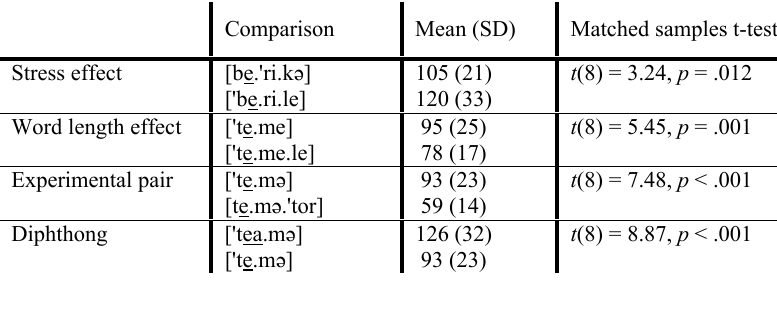
Table 2. Means, standard deviations and results for matched-samples t-tests for the vowel duration measure. The vowel tested is underlined. Descriptive statistics are in milliseconds.